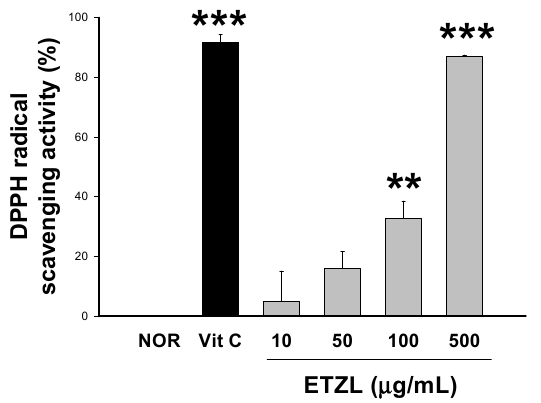
Figure 2. DPPH radical scavenging activity of ETZL. Vitamin C was used as a positive control. Values are expressed as mean ± SD ( n = 3). Significant differences compared with the normal (NOR) are indicated by ** p < 0.01, *** p < 0.001.